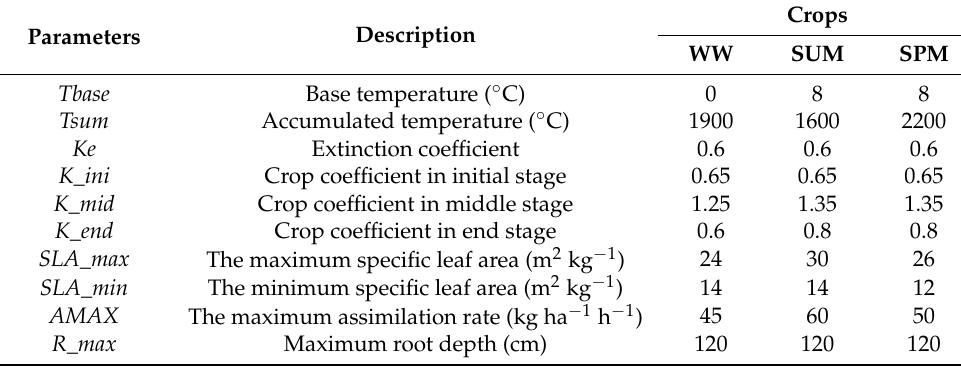
Table 3. Crop parameters used in the WHCNS model.